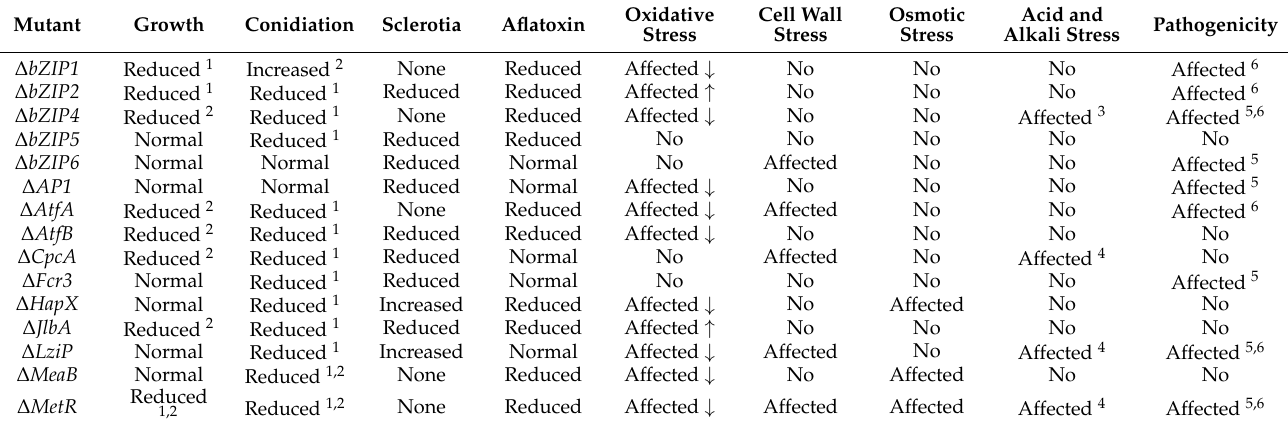
Table 1. Phenotypic summary of 15 bZIP transcription factor gene-deleted mutants.